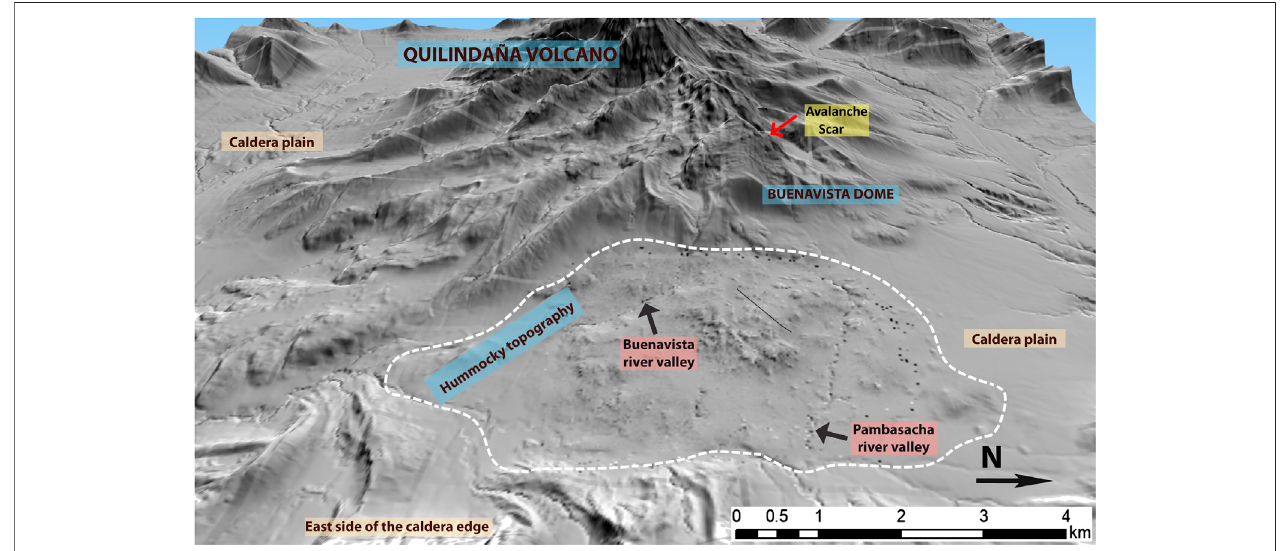
FIGURE 10 | 3D model of Buenavista dome, where hummocky topography spreads out from the eastern foot of Buenavista Dome. Top of scar indicated by red arrow. View to west.